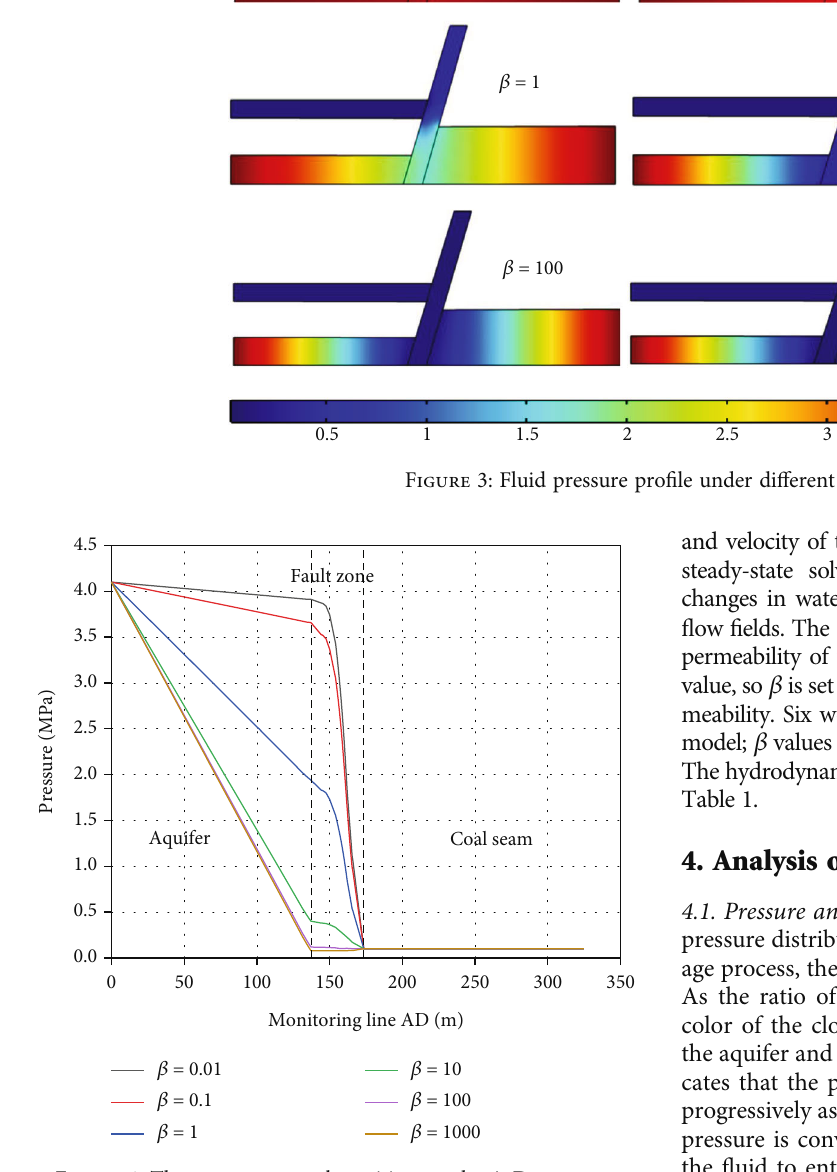
Figure 4: The pressure at each position on the A-D